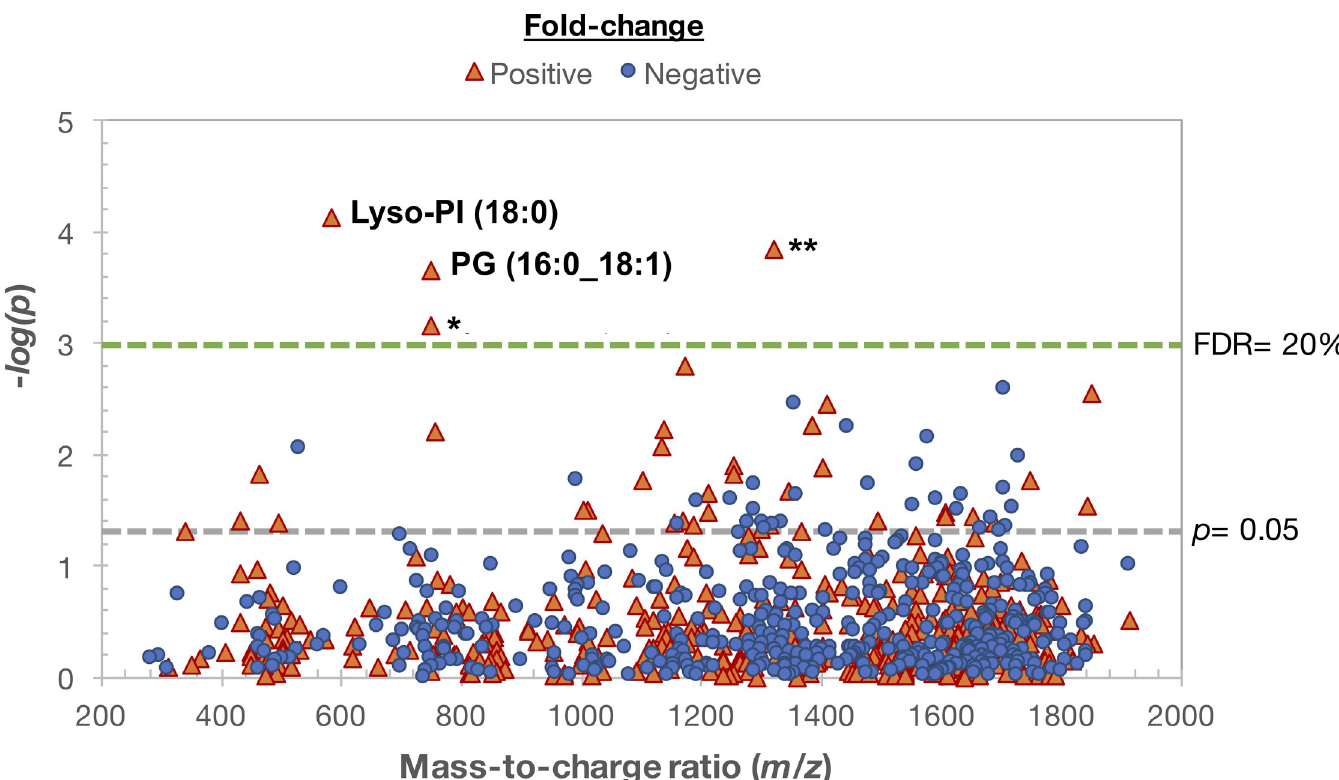
Fig 1. Mycobacterium tuberculosis ( Mtb) lipid suspects in plasma of adults with active pulmonary TB compared to their household contacts. The Manhattan plot depicts the -log p statistical analysis of 867 features identified using plasma high-resolution metabolomics (HRM) as Mtb -associated metabolite suspects based on accurate mass/charge ( m/z) matches. Analysis was done in a cross-sectional comparison of plasma from 17 adults with sputum culture-proven TB disease (within 7 days of diagnosis and initiation of anti-TB drugs) and 16 of their asymptomatic adult household contacts, who were sputum smear and culture negative for Mtb . Sixty-nine metabolites were significant at raw p � 0.05 (points above gray line) and four were significant using a more stringent false discovery rate (FDR) threshold of 20% (red triangles above green line). The negative log 10 statistical p-value of metabolites between the two groups are shown on the y-axis as a function of metabolite m/z (x-axis). � Chemical verification experiments revealed the metabolite with m/z 749.3714 was likely a source fragment of 25-desacetyl rifampin. �� m/z 1321.9177 was predicted as acylphosphatidylinositol mannoside (Ac1PIM1) (56:1) based on accurate mass and retention time measurements, but could not be confirmed using tandem MS/MS;